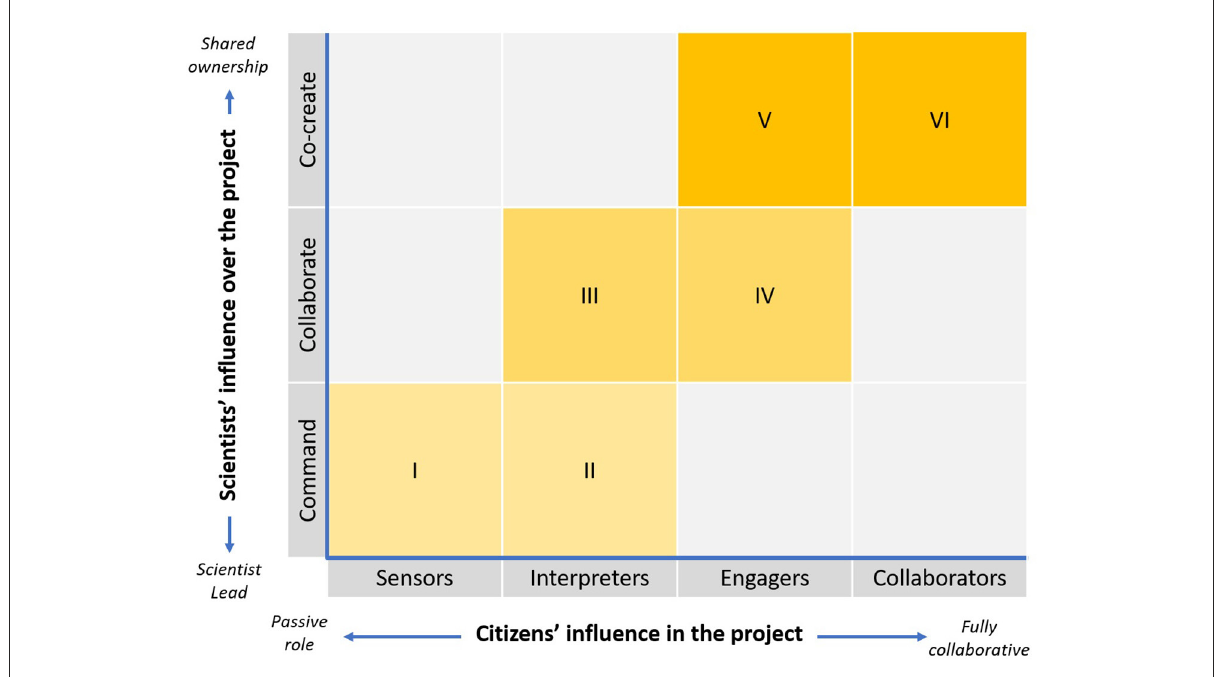
FIGURE2 Typology of citizen science projects based on citizens’ and scientists’ level of influence (WMO,